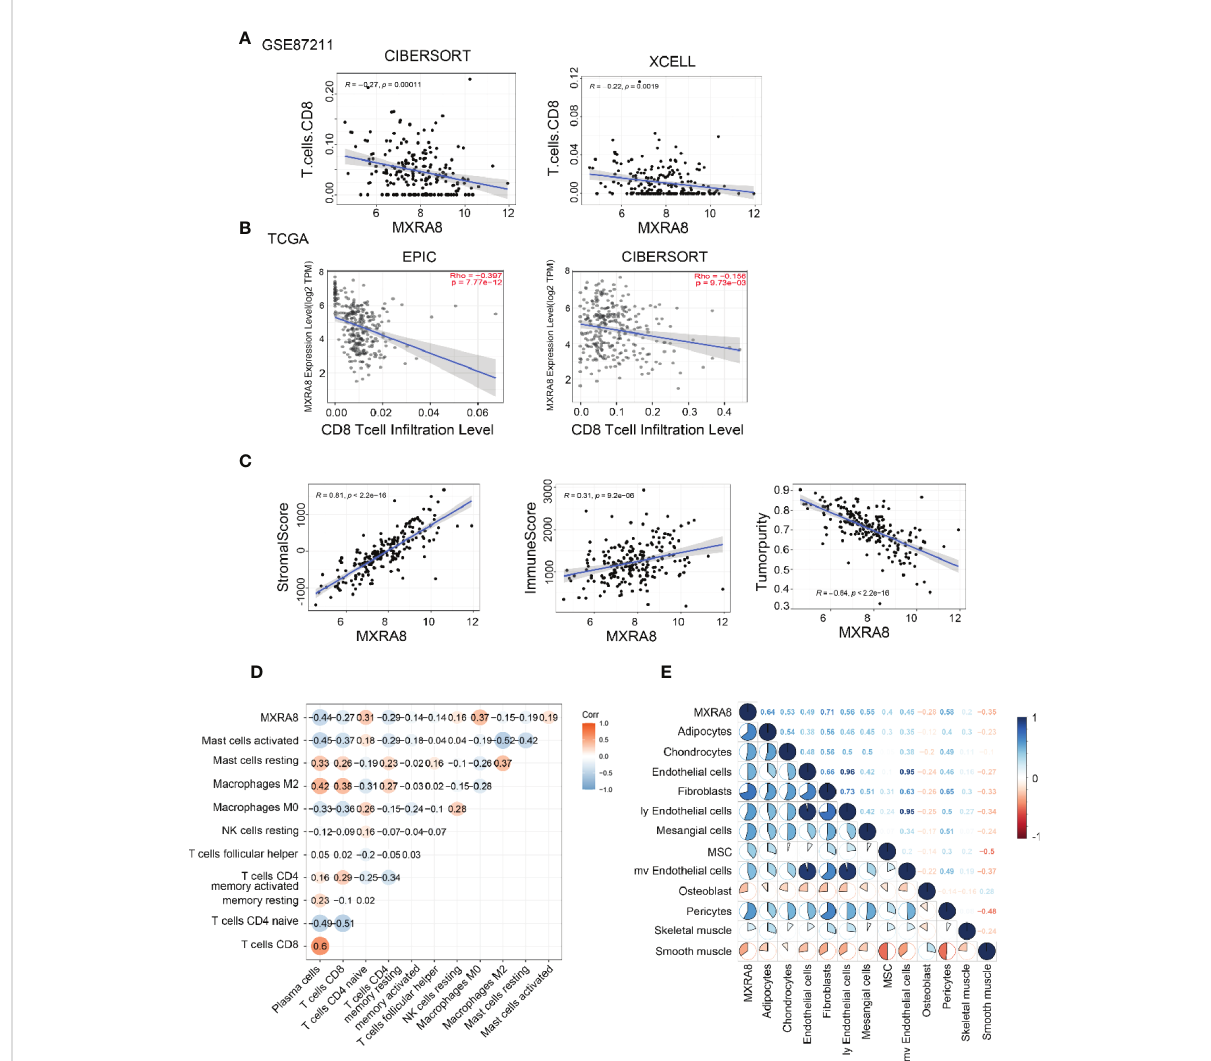
FIGURE 6 High MXRA8 expression correlates with low CD8 + T cell in fi ltration level. (A) The protein expression of MXRA8 is negatively correlated with CD8 + T cell in fi ltration level in GSE87211 with CIBERSORT and XCELL algorism. (B) The mRNA expression of MXRA8 is negatively correlated with CD8 + T cell in fi ltration level in TCGA with EPIC and CIBERSORT algorism. (C) The protein expression of MXRA8 is positively correlated with a stromal score and immune score but negatively associated with tumor purity. (D) Correlation analysis between MXRA8 expression levels and immune cells (E) Correlation analysis between MXRA8 expression levels and stromal cells in fi